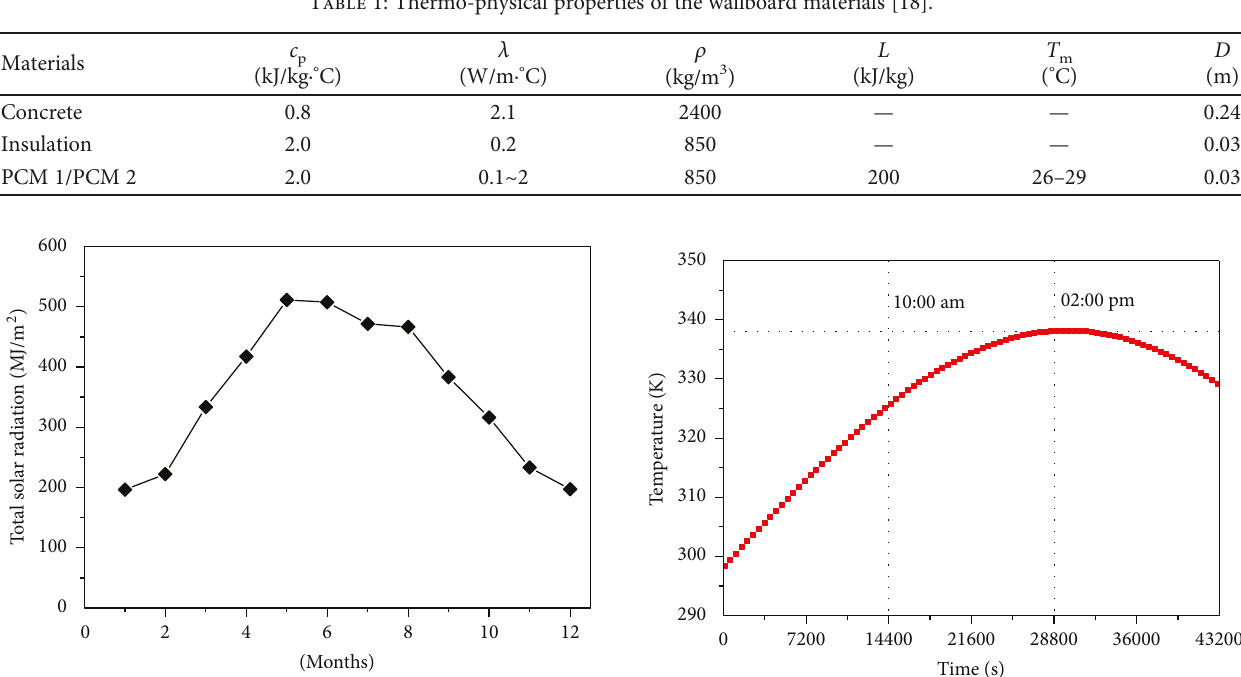
Figure 4: Temperature variation of the outside wall at di ff erent moments in summer.